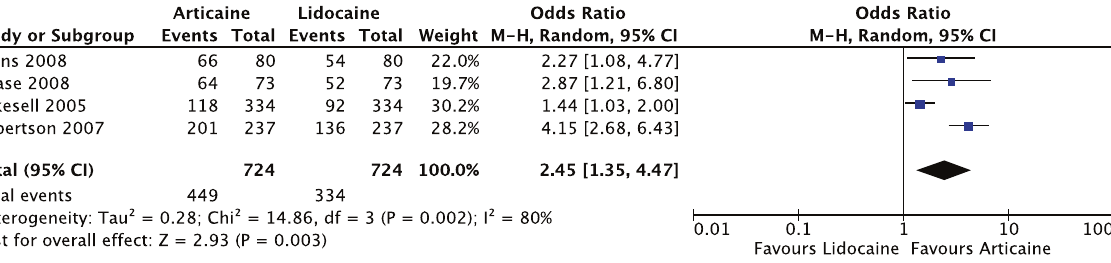
Fig. 14 Forest plot — all crossover randomised controlled trial studies. Articaine had 2.45 times likelihood of anaesthetic success of